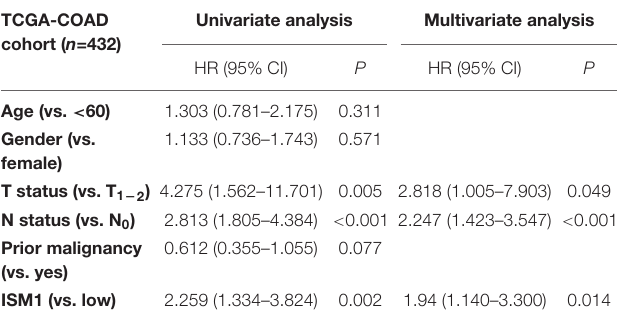
TABLE 1 | Univariate and multivariate analysis of clinicopathological characteristics and ISM1 with overall survival in TCGA-COAD cohort. TCGA-COAD cohort ( n